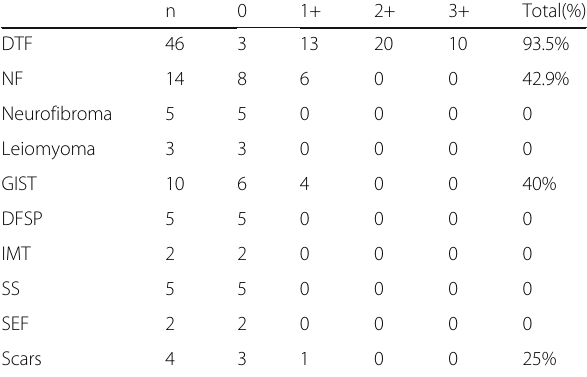
Table 2 TFE3 immunohistochemical staining results